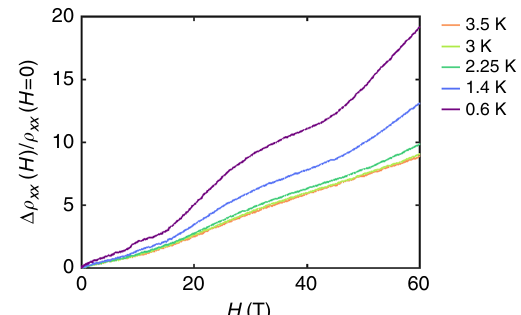
magnetoresistance curves of a 1.2-nm-thick LTO fi lm on STO at low